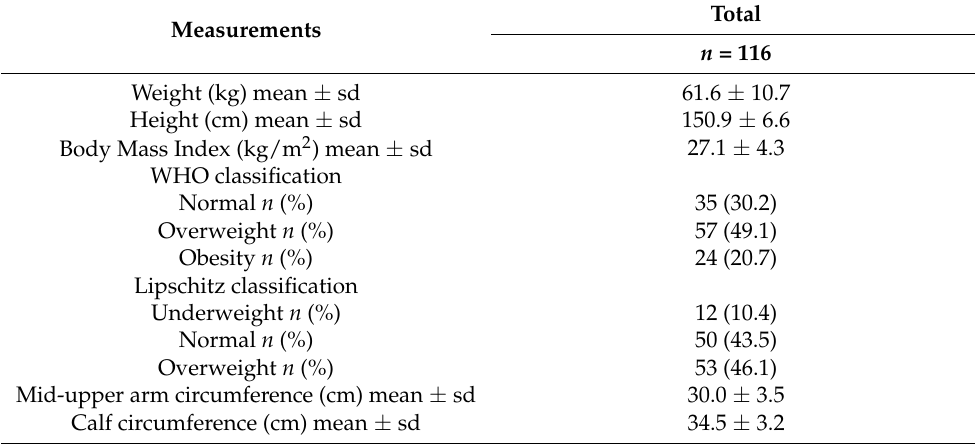
Table 2. Anthropometric characteristics of community dwelling Mexican older women.